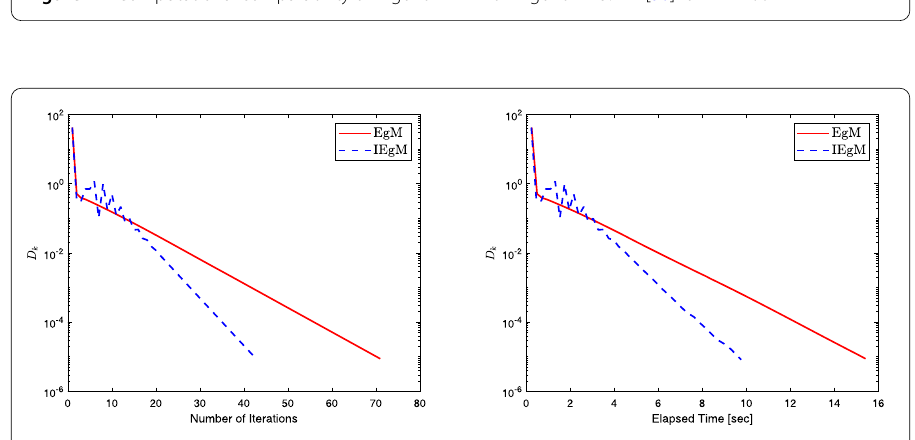
Figure 13 Computational comparability of Algorithm 2 with Algorithm 3.1 in [36] for M = 200